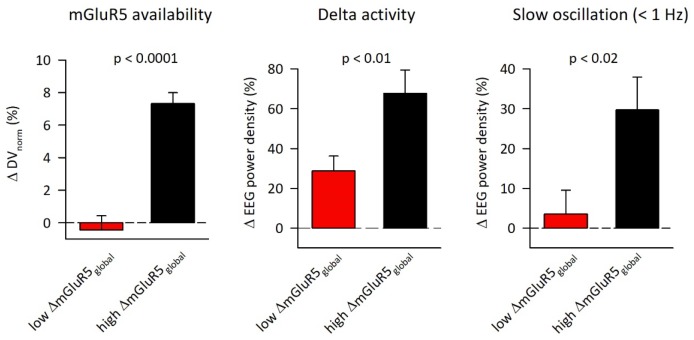
Enhanced rebound after sleep deprivation in EEG delta (0.5–4.5 Hz) and <1 Hz activity in individuals with high change in global mGluR5 availability after sleep deprivation.The EEG data were quantified in NREM sleep episode 1. Red bars: low mGluR5 responder group (n = 12); black bars: high mGluR5 responder group (n = 11). Data represent means ±SEM.